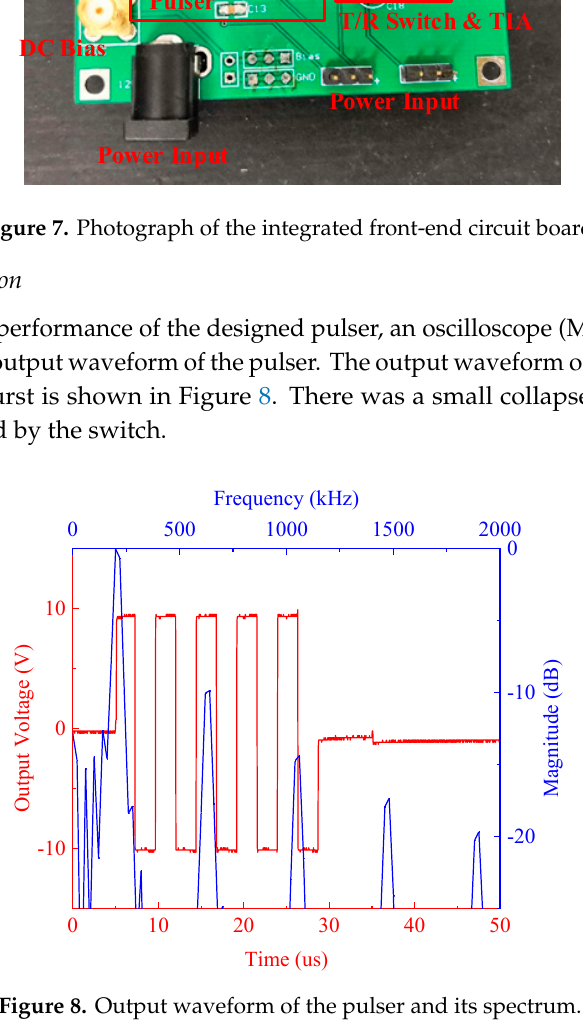
Figure 8. Output waveform of the pulser and its spectrum.